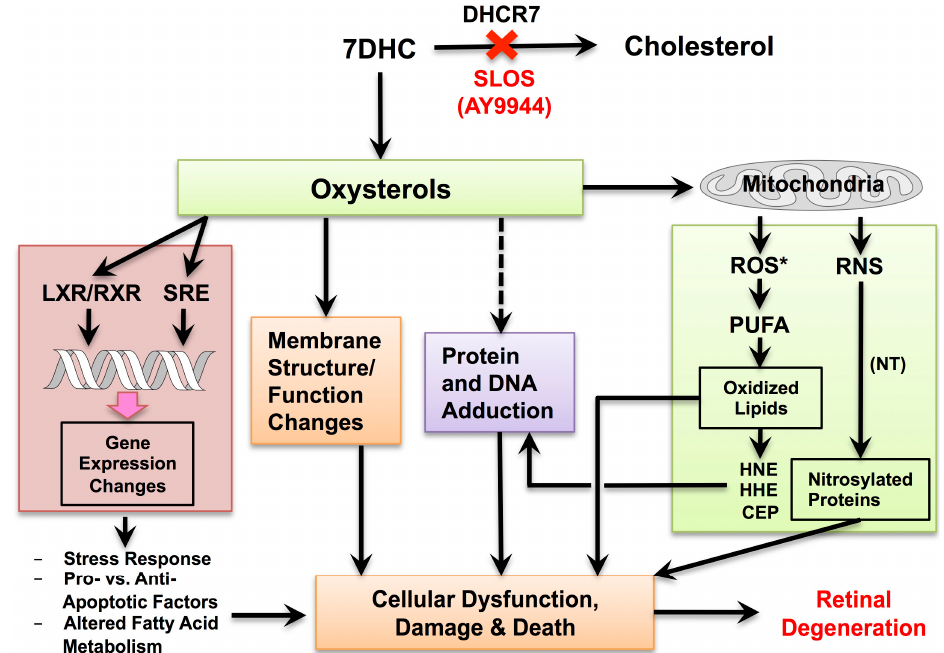
Figure 5. Schematic illustrating hypothetical mechanisms underlying retinal degeneration in the AY9944-induced rat model of SLOS and the therapeutic potential of antioxidants to prevent or minimize the degeneration. Abbreviations: LXR, liver X-receptor; RXR, retinoid X-receptor; SRE, sterol response elements; ROS*, reactive oxygen species; RNS*, reactive nitrogen species; HHE, 4-hydroxynonenal; HHE, 4-hydroxyhexenal; CEP, carboxyethylpyrrole; NT, nitrotyrosine; other abbreviations as described in text ( Adapted from Figure 29 in [63] with permission .).